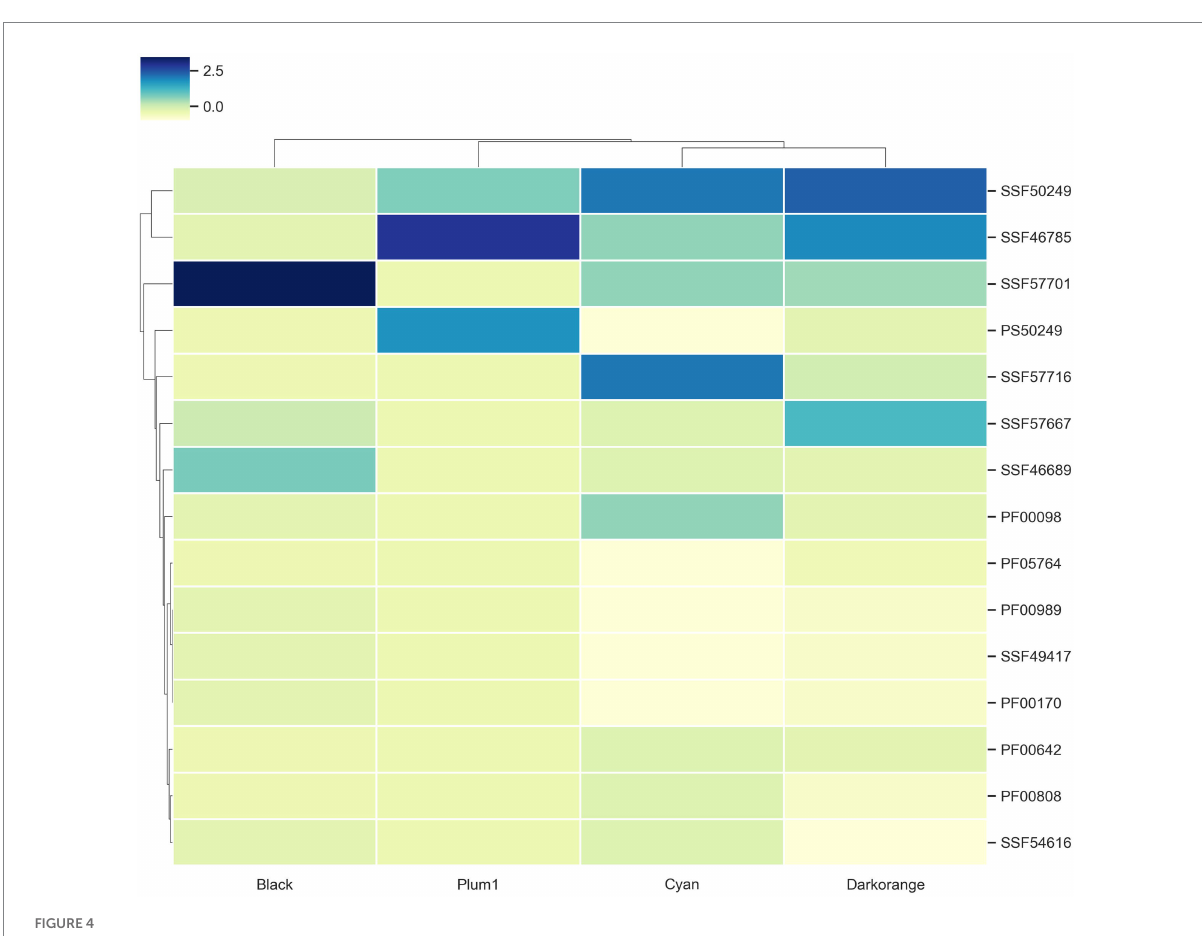
carbon and nitrogen metabolism, amino acid and